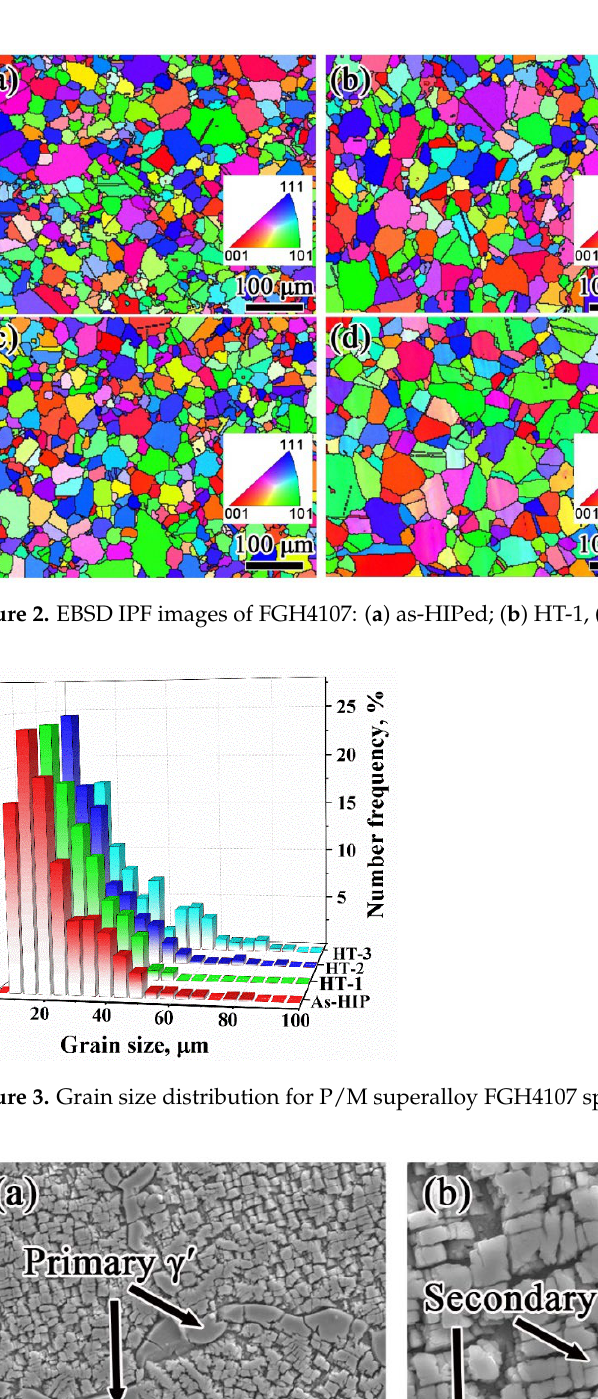
Figure 4. γ′ morphologies of FGH4107 after hot isostatic pressing : ( a ) primary γ′; ( b ) secondary γ′ .